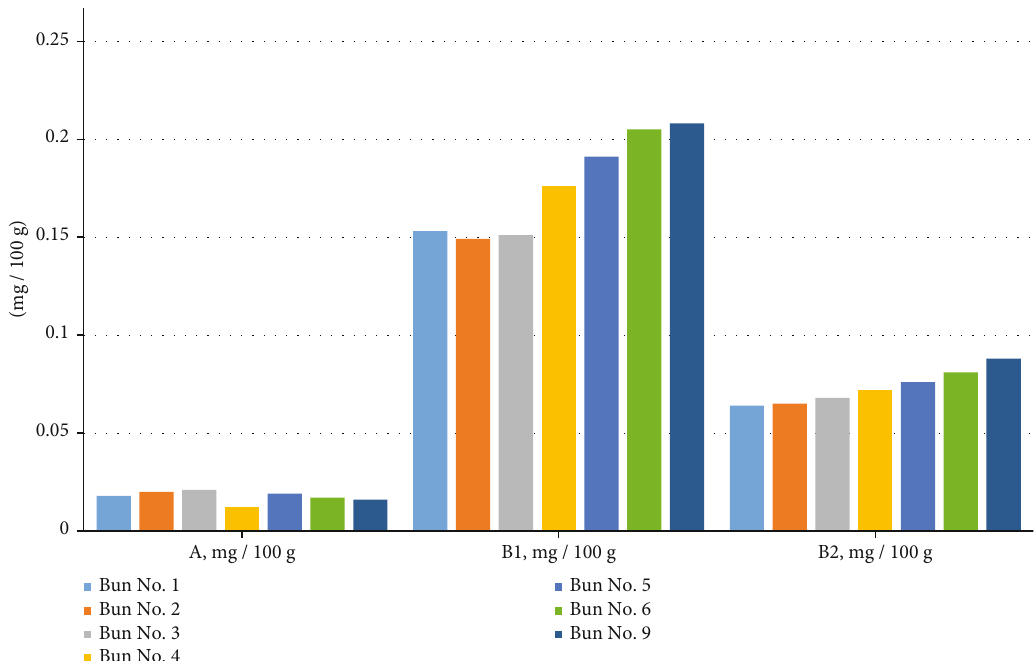
Figure 16: Content of vitamins A, B1, and B2 in the various bun